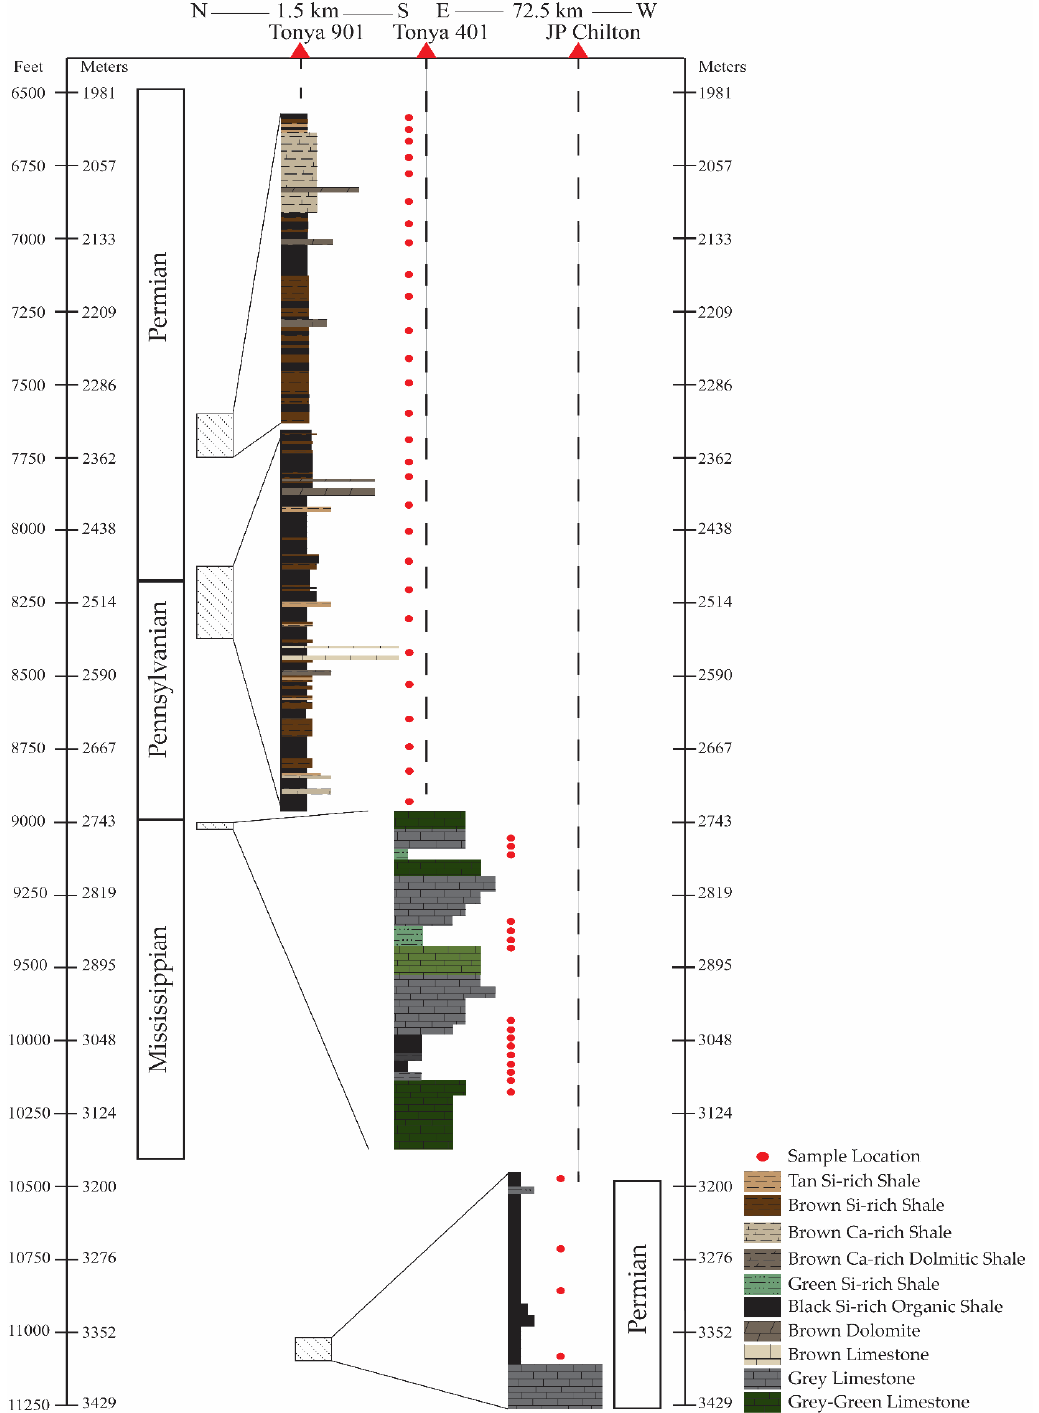
Figure 4. Stratigraphic column of the Tonya 401, Tonya 901, and JP Chilton cores used for this study. Core intervals are exaggerated to depict grain size and lithologies associated to the sampling interval. Vertical scale 1in. = 76.2 m (250 ft.). Refer to Figure 1 for well locations within the northern Midland